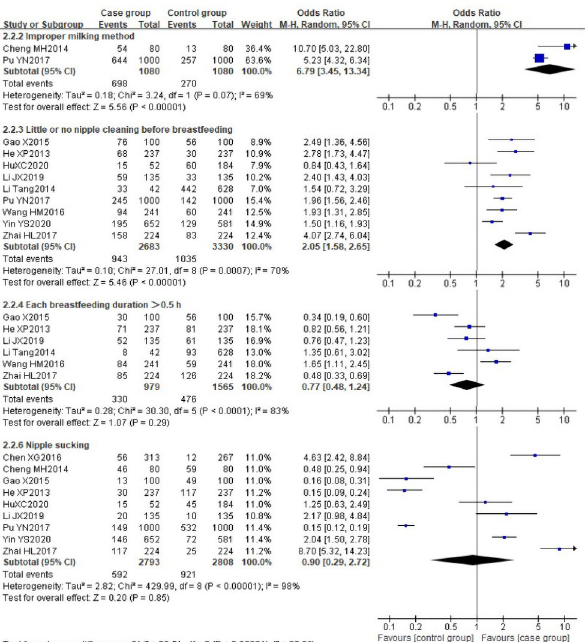
Fig 3. Forest plot comparing the pooled risks of improper milking method, little or no nipple cleaning before breastfeeding, each breastfeeding duration > 0.5 h and nipple sucking.